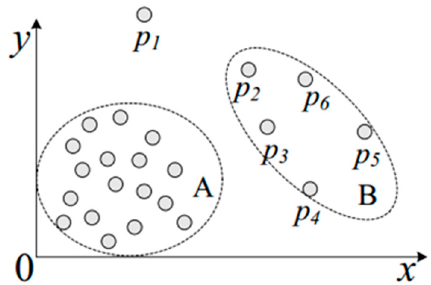
Figure 4. The illustration of the density-based outlier.